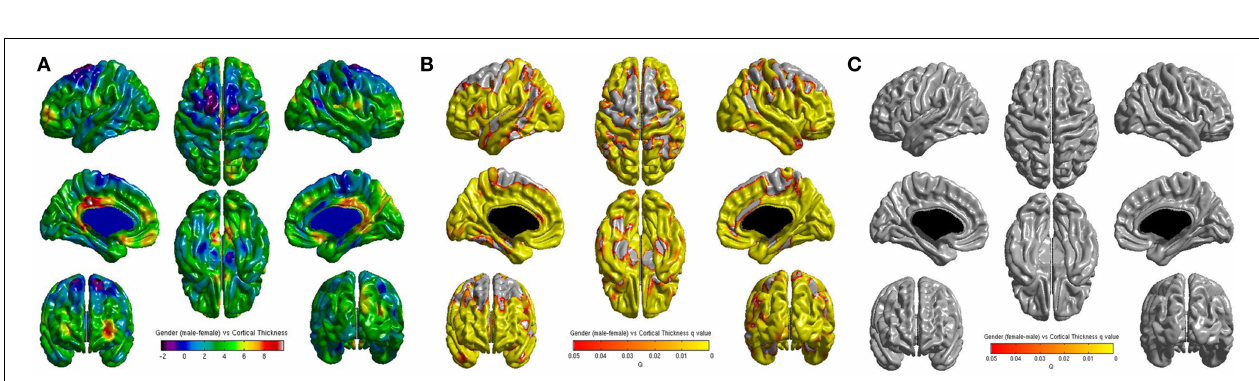
FIGURE 2 | (A) Unthresholded correlations between age and cortical thickness across the entire brain, shown here for comparison. (B) Positive correlations between age and cortical thickness across the entire brain